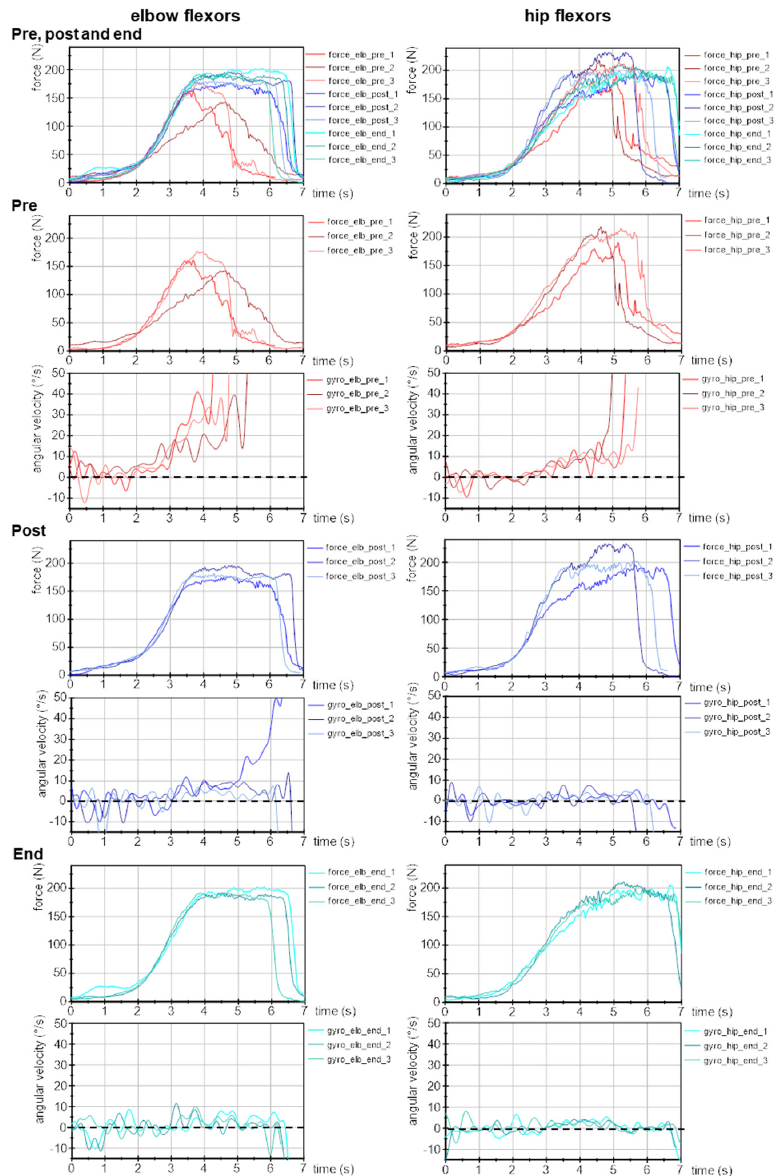
Figure 2. Exemplary signals of force and angular velocity during AF measurements of one female patient (24 yrs., 168 cm, 65 kg) recorded during three MMTs of elbow (left) and hip flexors (right) at time points pre, post and end (according to Schaefer and Bittmann [68]). Table 2. Parameters of the Adaptive Force (AF) of elbow and hip flexors. Arithmetic means ±